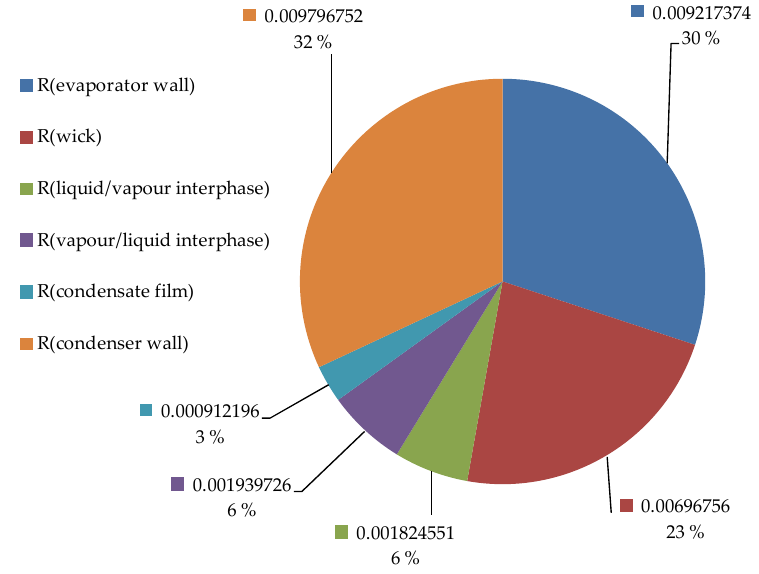
Figure 4. The importance of the considered thermal resistances [K/W] at T 5 ≈ 500 °C.